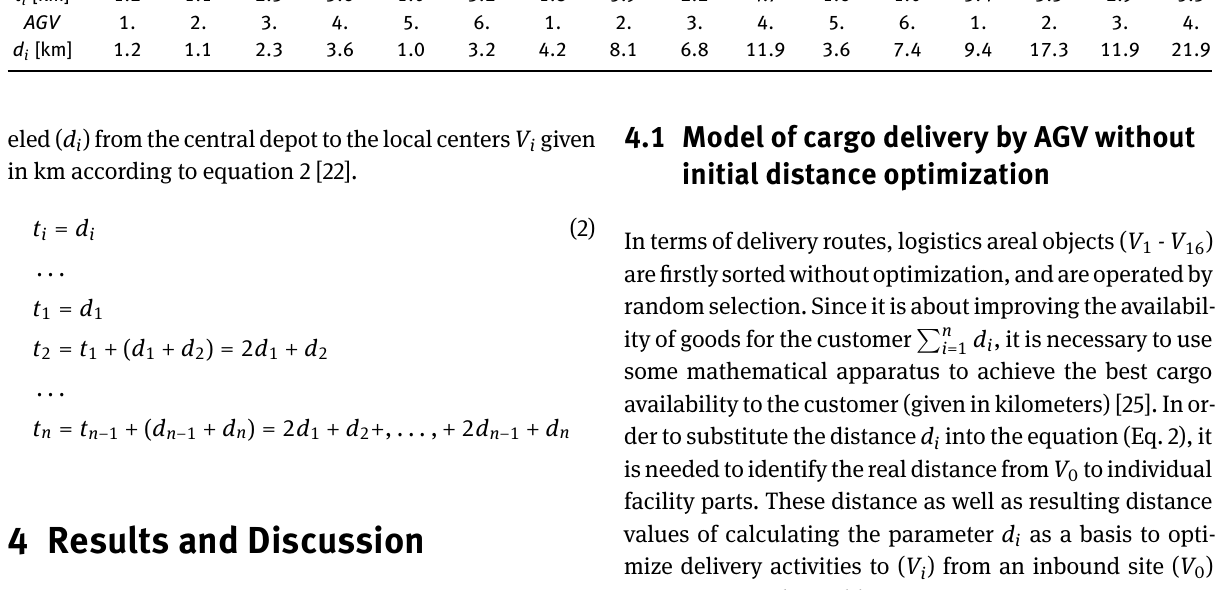
Table 4: Calculation of the d i parameter based on distances between V 0 and V i for six AGVs V i